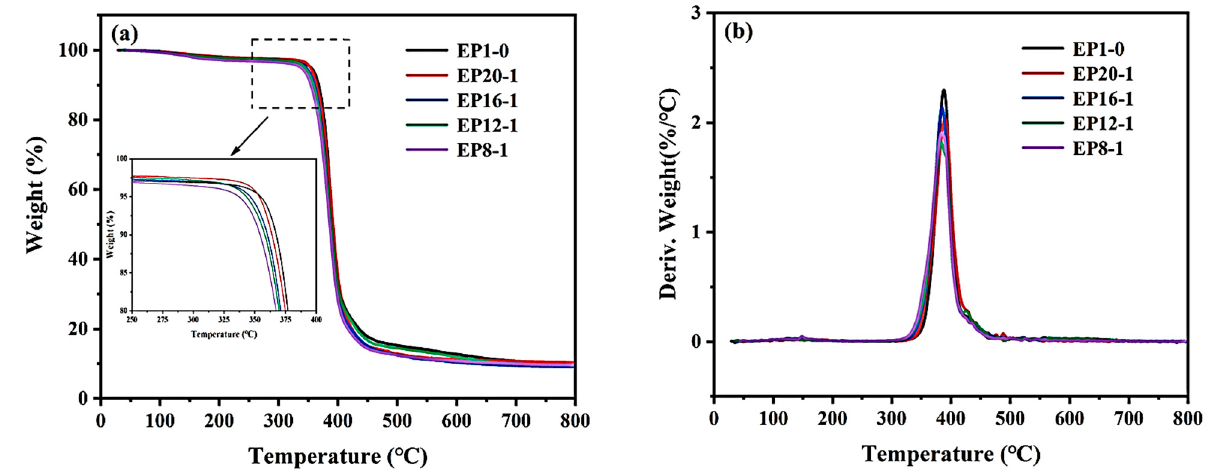
Figure 7. TGA curves ( a ) and DTG curves ( b ) of EPx samples.